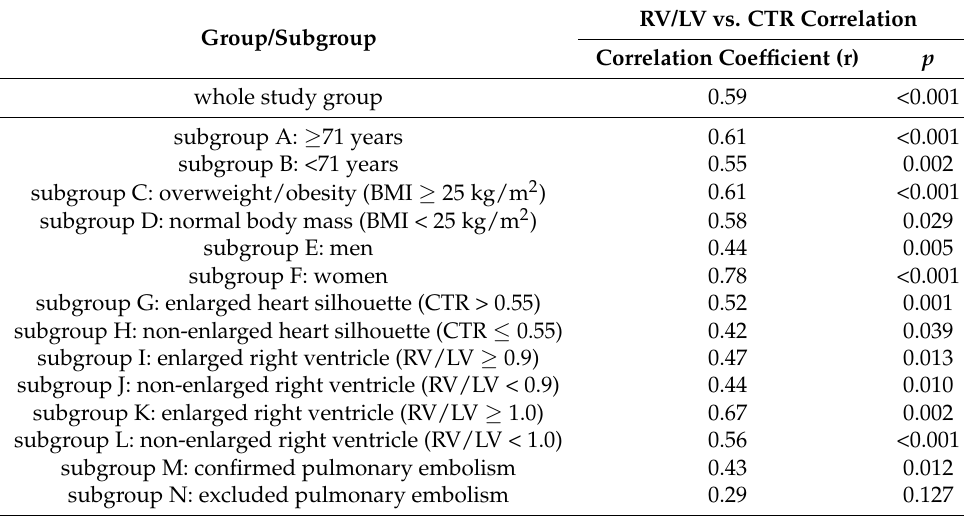
Table 5. Correlation of the size of the heart silhouette in the chest radiograph and the size of the right ventricle in the CTA of the pulmonary arteries in the study group and subgroups.